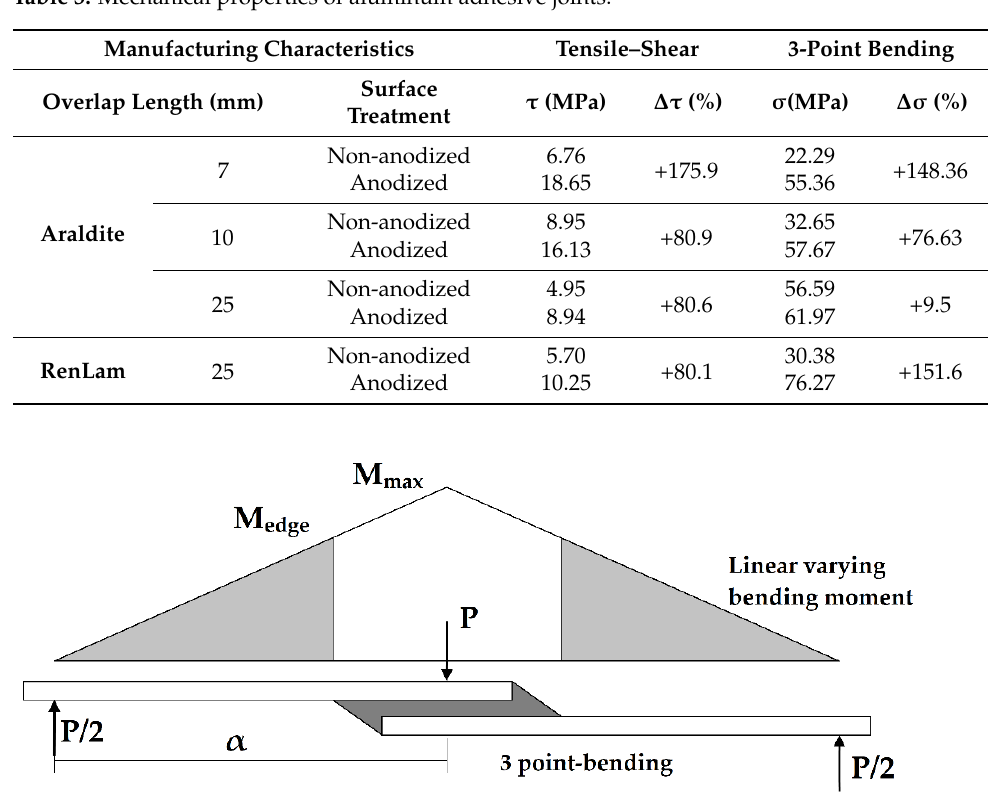
Figure 9. Bending moment diagram for a single-lap joint with small adhesive thickness under three-point bending loading. Table 3. Mechanical properties of aluminum adhesive joints.